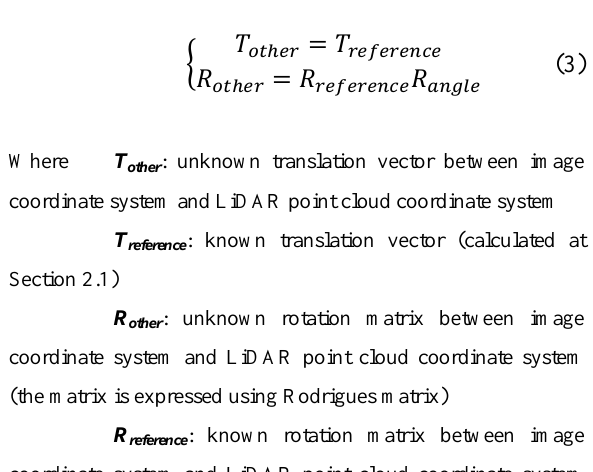
Figure 2. LiDAR point cloud